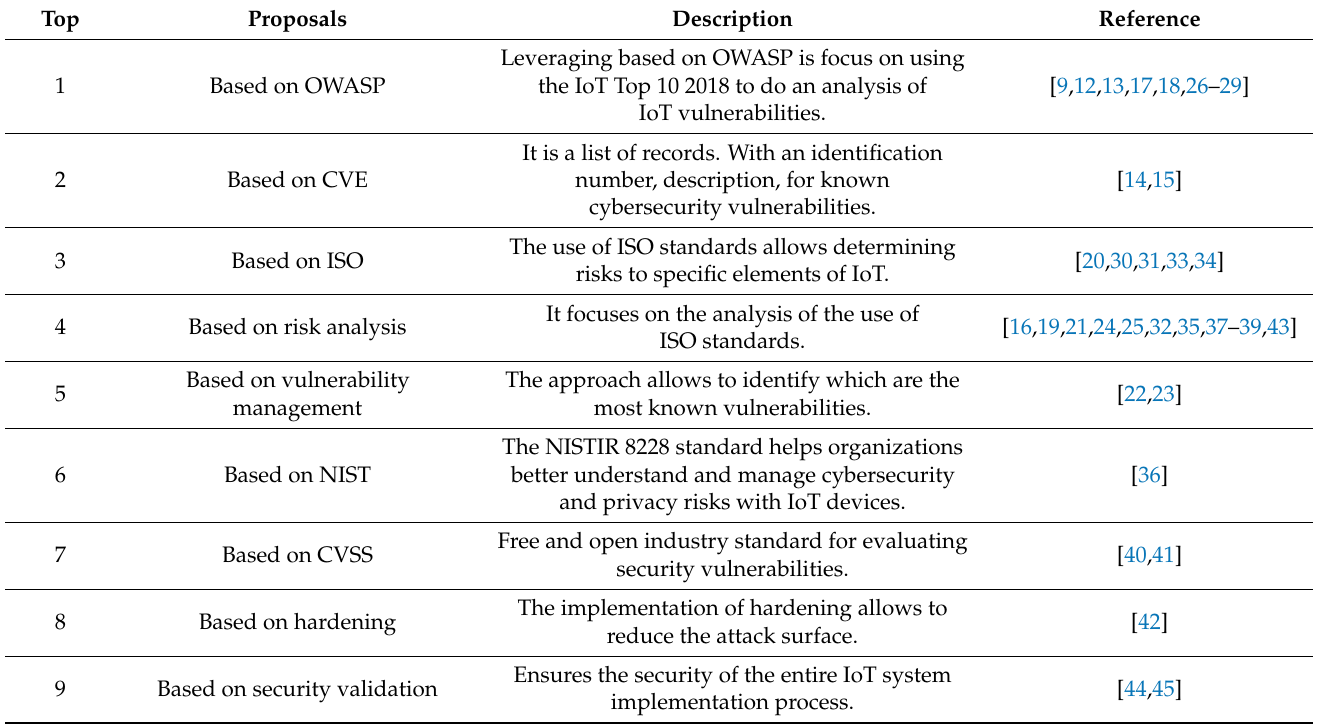
Figure 3. Word cloud generated by Rayyan based on the records identified in the Systematic Literature Review (SLR). Table 3. Results of the selected papers to